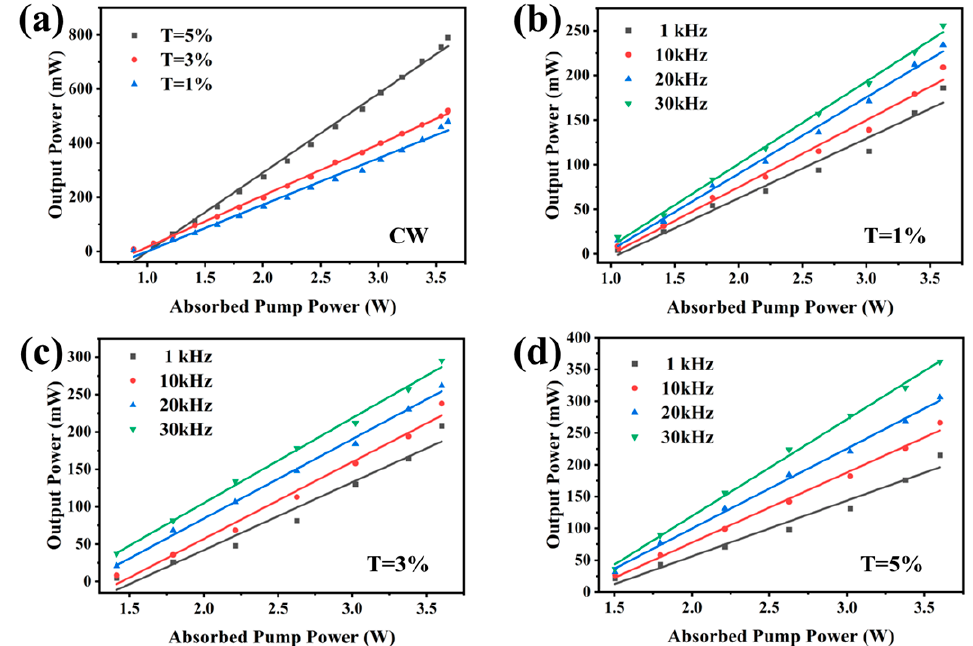
Figure 4. The dependences of CW and AO Q-switched output power on absorbed pump power, ( a ) CW; ( b – d ) Q-switched: b for T = 1%, c for T = 3% and d for T = 5%.